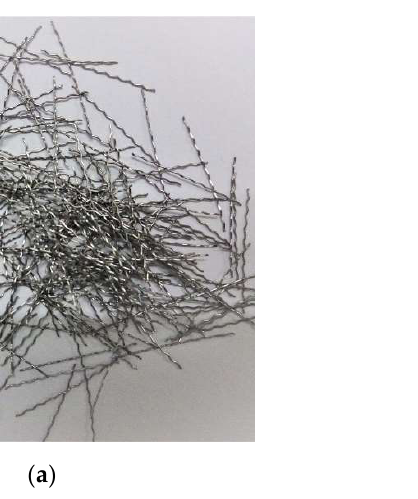
Figure 1. Fibres used: ( a ) Crimped steel fibres; ( b ) Polypropylene fibres. Table 4. Properties of fibres. Table 4. Properties of